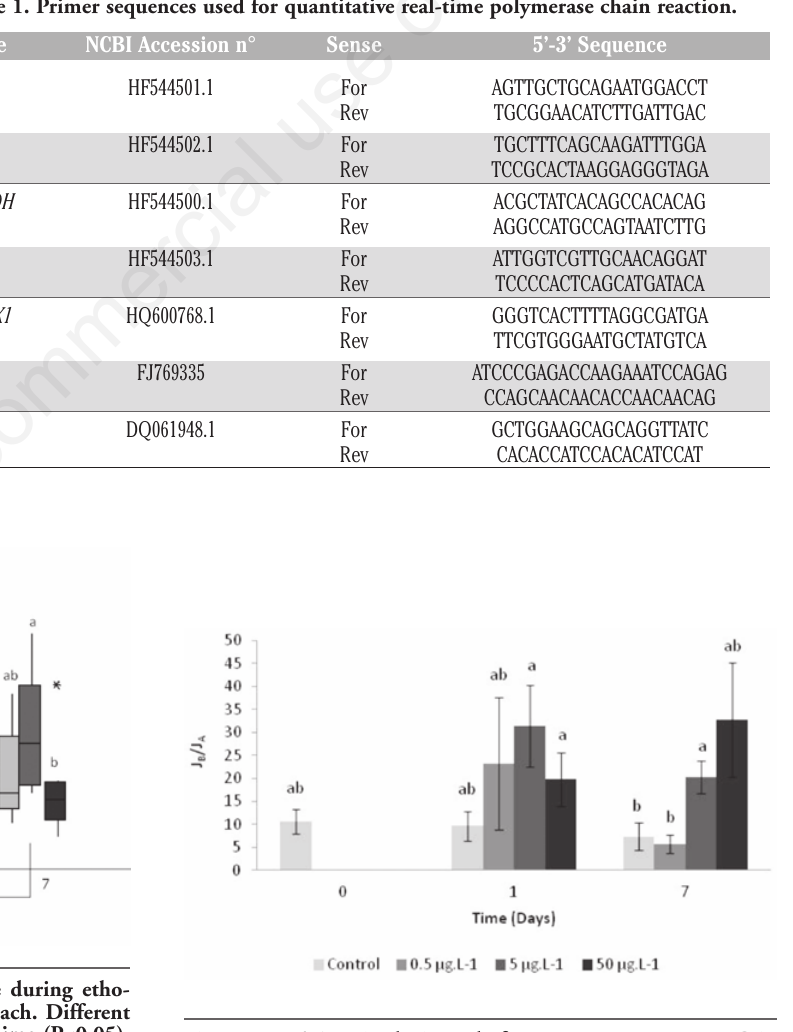
Figure 2. JB/JA ratio during ethofumesate exposure at 17°C in white muscle of roach. Different letters indicate significant dif-